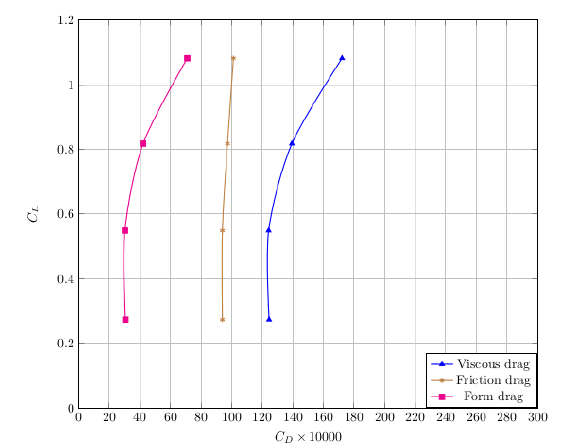
Figure 15. NLF wing body, M ∞ = 0.64, Re ∞ = 18.2 × 10 6 . Viscous drag breakdown with NLF and riblets [35].